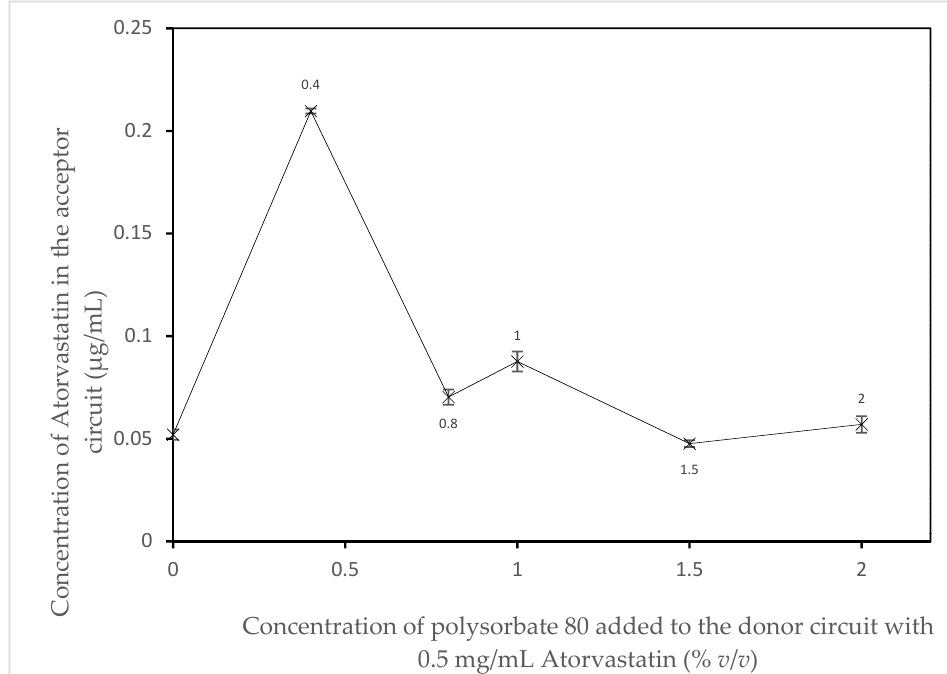
Figure 4. The effect of super refined polysorbate 80 LQ on the absorption of Atorvastatin in the duodenum section of ex vivo porcine small intestine ( n = 3).